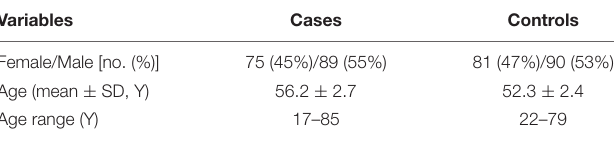
TABLE 1 | Demographic data of cases and